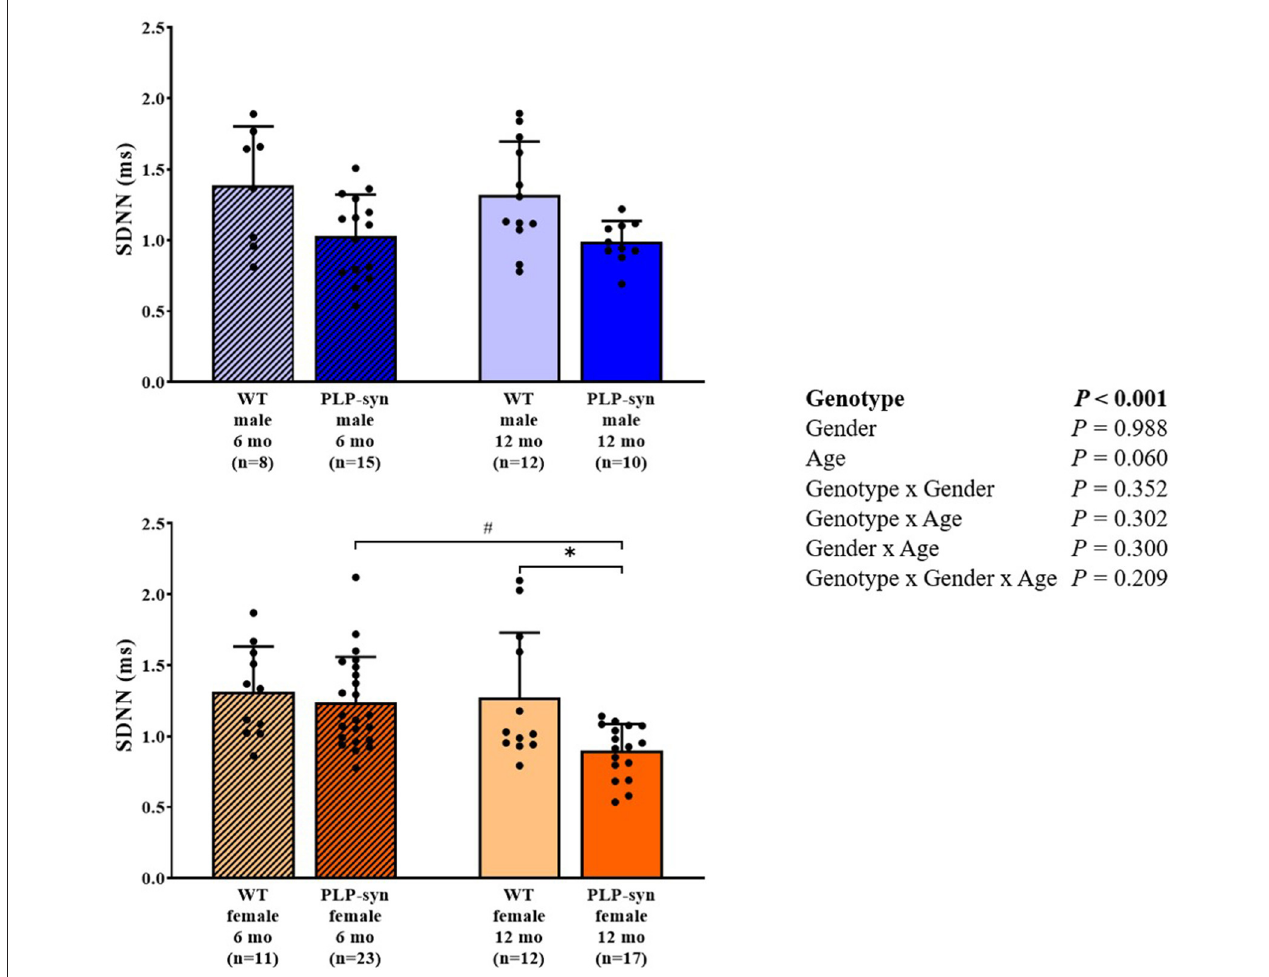
FIGURE 1 | SDNN in 6 and 12 months, male and female, WT and PLP- α -syn mice. SDNN, standard deviations of normal-to-normal intervals. # P < 0.05 vs. PLP- α -syn female 6 mo, * P < 0.05 vs. WT female 12 mo. Black circles represent individual